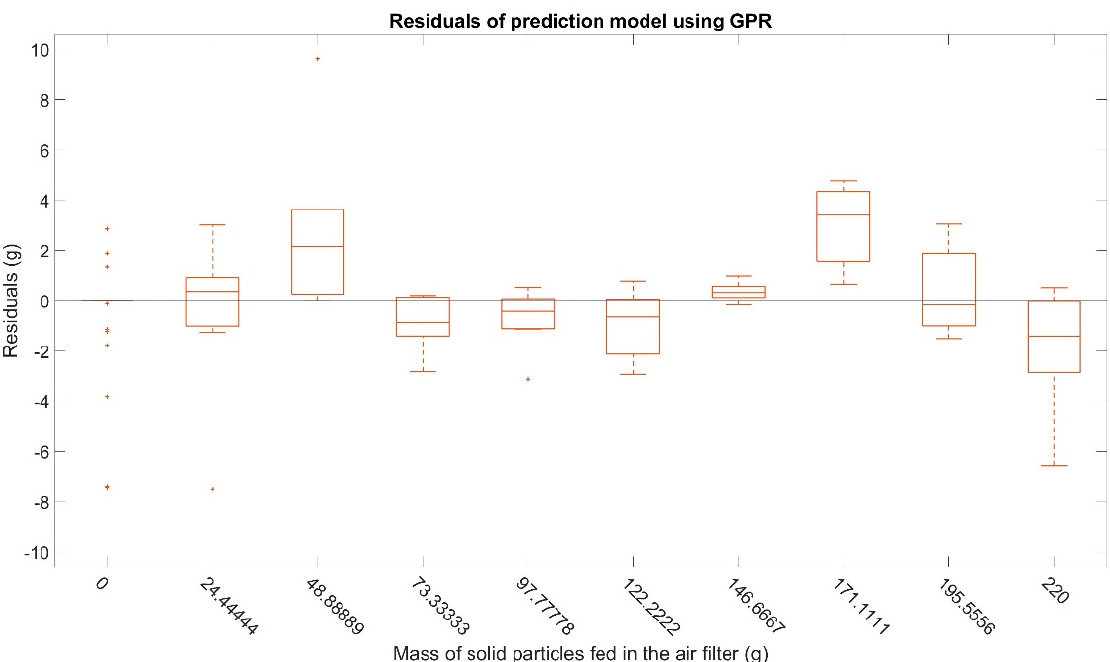
Figure 10. Residuals obtained after the validation of the Gaussian process regression model.